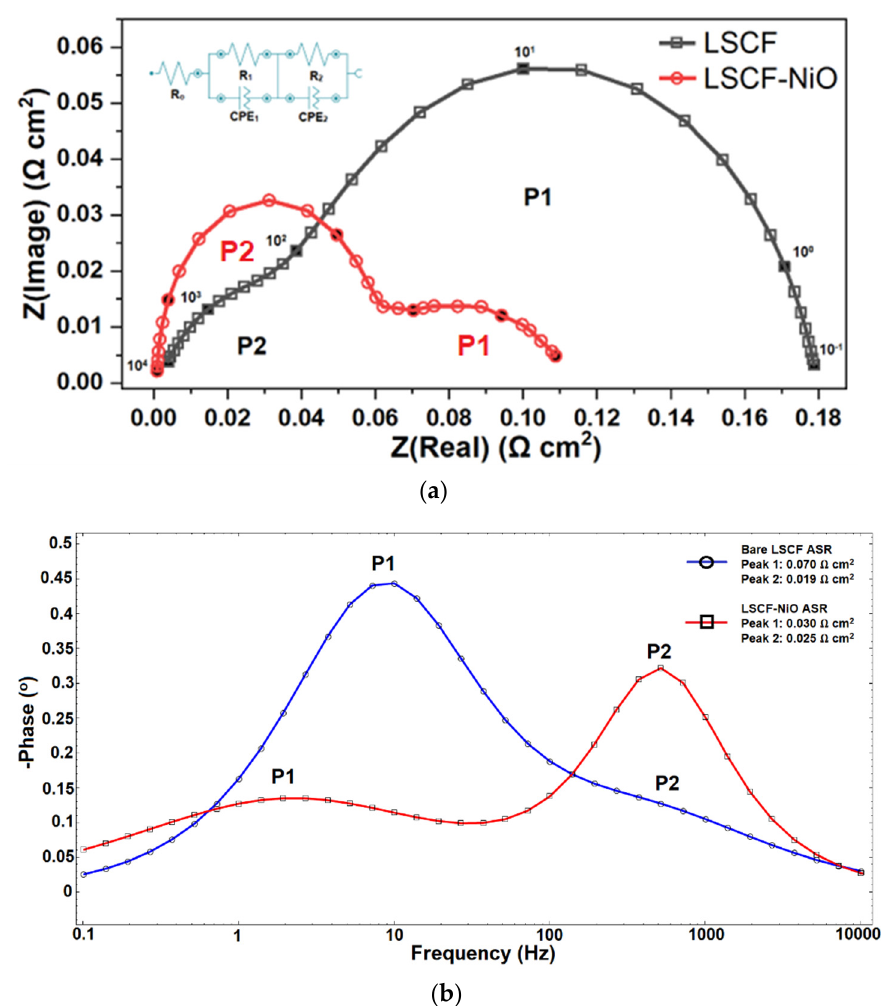
Figure 4. ( a ) Electrochemical impedance spectra measured at 800 °C for a bare LSCF symmetric cell and LSCF with 5 wt% NiO symmetric cell and their respective bode phase results are shown in ( b